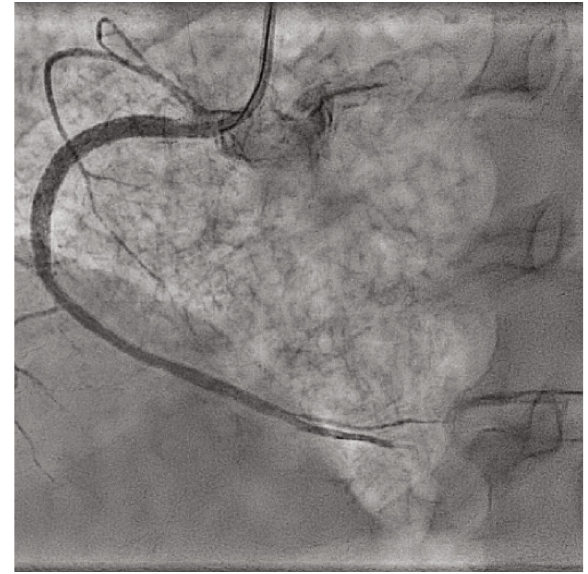
Figure 3: Right coronary artery (RCA) postpercutaneous intervention